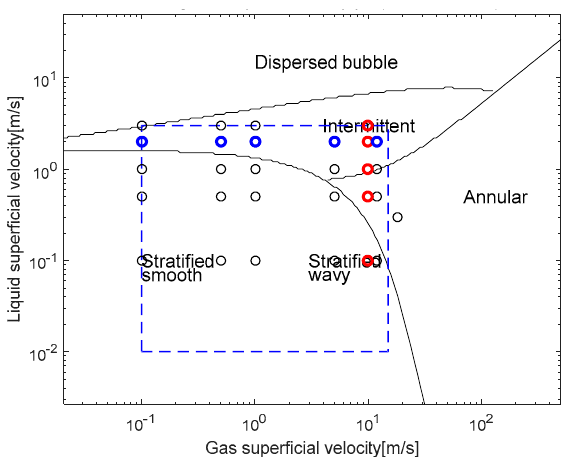
Figure 8. Investigated flow conditions marked on the flow regime map by Taitel and Dukler [23] (the colored marks indicate the selected runs to be discussed in Section 4.2. Measurement Results. The reds are to investigate the effect of the liquid velocity at a fixed gas velocity, whereas the blues indicates tests performed at a fixed liquid velocity with varying the gas velocity. The dash-line box encloses the testable ranges in the JNU two-phase flow loop).